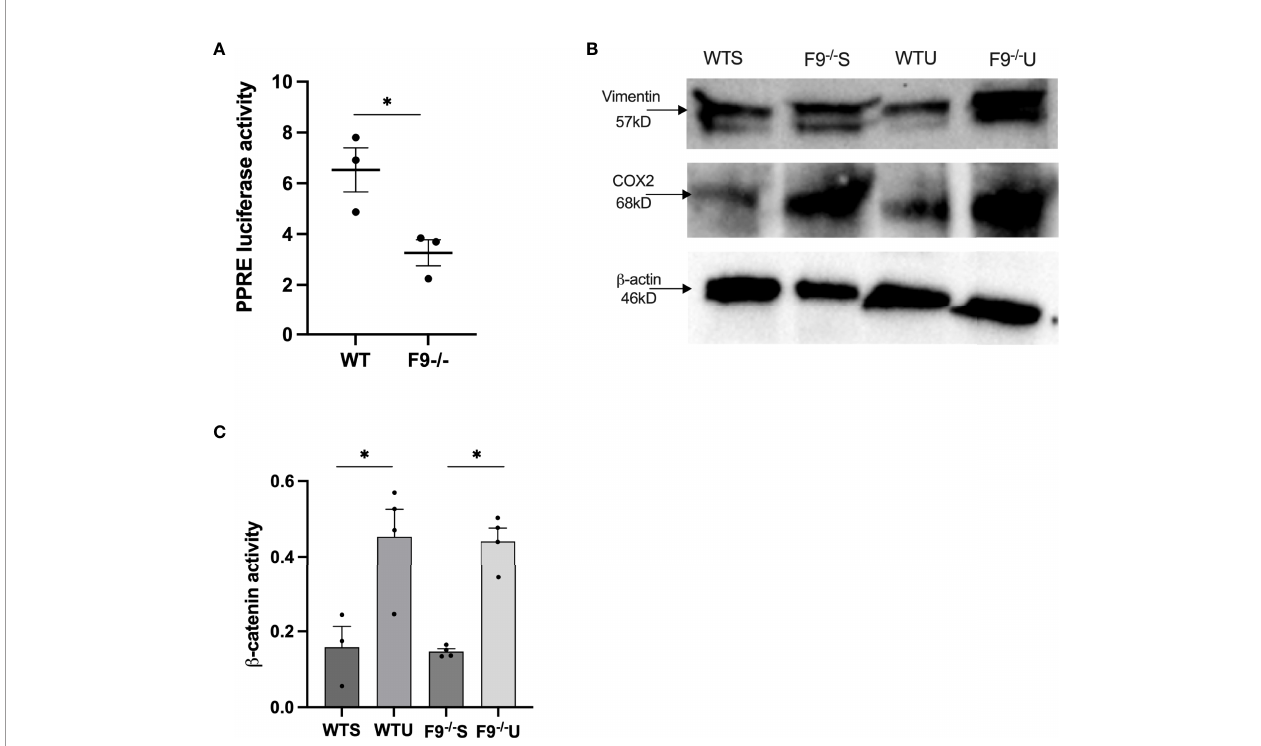
FIGURE 4 | Loss of FZD9 in vivo alters downstream target activity. (A) HEK293t cells were transfected with PPRE-luc and treated with 10ul mouse serum from wild type or FZD9 -/- mice. Signi fi cance was measured by two-tailed t-test and *p<0.05 (B) Protein was extracted from whole lung samples from wild type or FZD9 -/- mice exposed to saline or urethane and analyzed for vimentin and COX2 protein expression, with b -actin as a loading control. (C) Active b -catenin was measured by ELISA in wild type or FZD9 -/- mice treated with saline or urethane. The assay was conducted in triplicate. Signi fi cance was measured by one-way ANOVA with Tukey ’ s post hoc analysis and *p>0.05. WT, wild type; F9-/-, FZD9 knockout; WTS, wild type saline; F9 -/- S, FZD9 -/- saline; WTU, Wild type urethane; F9 -/- U, FZD9 -/-